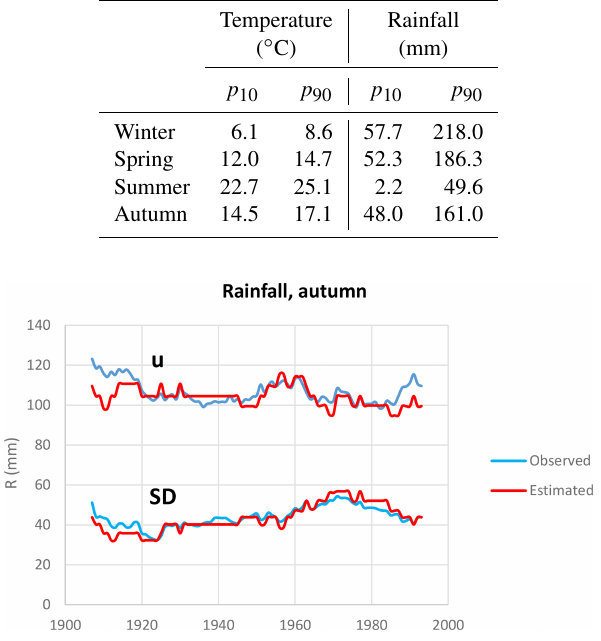
Figure 3. Calibration of the reconstruction method for autumn rain- fall in Granada from 1805 to 2005. u : mean value; SD: standard deviation.